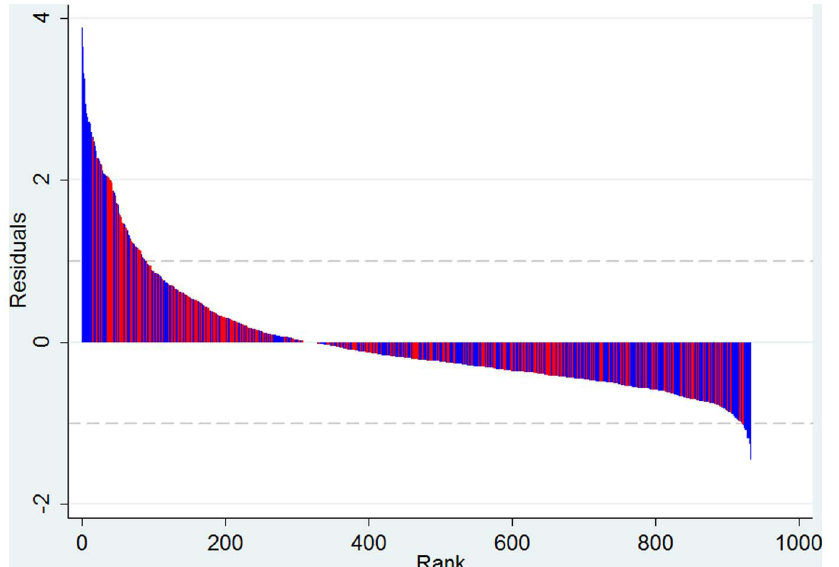
Figure 2. Ranking of residuals from the scaling regression for year 2008 (MSA observations in red; micropolitan area observations in blue).